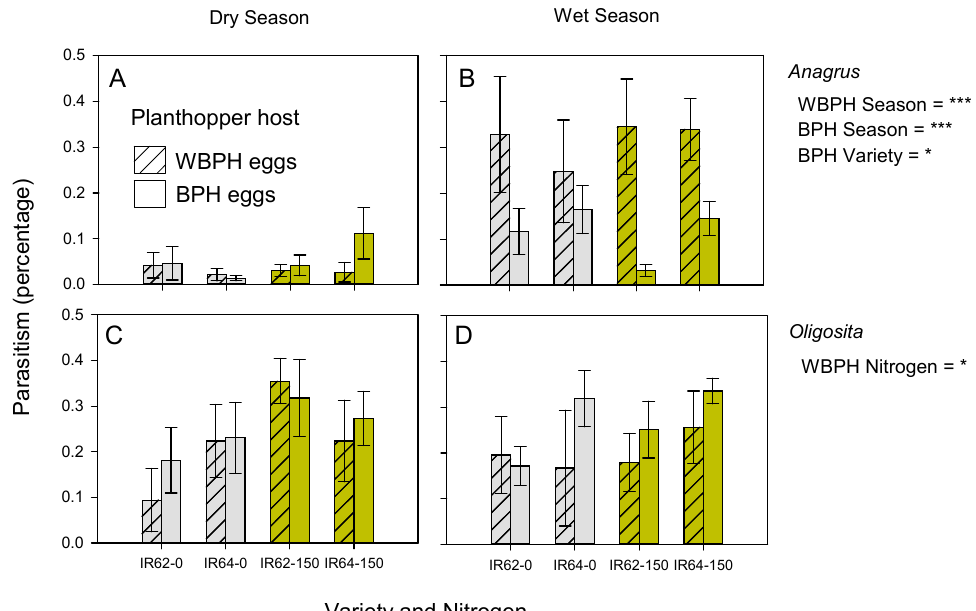
Figure 3. Effects of nitrogen (0 or 150 Kg ha − 1 of nitrogen) and variety (IR62: resistant and IR64: susceptible) on parasitism of WBPH and BPH eggs by Anagrus spp. and Oligosita spp. in field plots. Experiments were conducted during the dry ( A , C ) and wet ( B , D ) seasons of 2013. Standard errors are indicated (N = 6); results of GLMs are indicated as * = p ≤ 0.05 and *** = p ≤ 0.001. BPH = brown planthopper and WBPH = whitebacked planthopper.